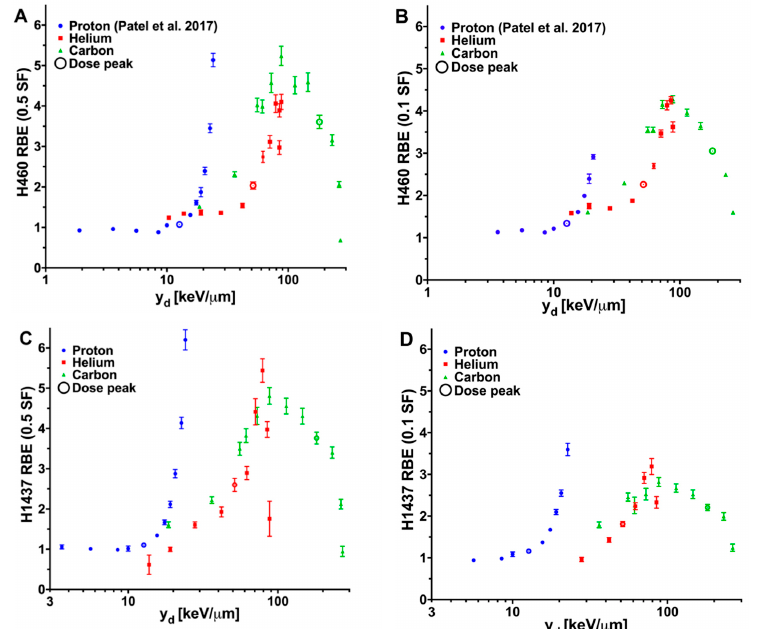
Figure 4. Proton, helium and carbon ion relative biological effectiveness (RBE) versus y d . RBEs were calculated at surviving fractions of 0.5 (RBE (0.5 SF)) and 0.1 (RBE (0.1 SF)). Irradiations at the Heidelberg Ion Therapy Center consisted of exposing cells to protons (blue), helium ions (red), and carbon ions (green). Previously published results for cells exposed to protons at the MD Anderson Proton Therapy Center are shown (purple). The location sampled closest to the Bragg peak is designated with a circle. ( A ) H460 RBE (0.5 SF). ( B ) H460 RBE (0.1 SF). ( C ) H1437 RBE (0.5 SF). ( D ) H1437 RBE (0.1 SF). The helium and carbon ion datasets demonstrated a measured increase in RBE until a y d value between 79.0 and 87.9 keV/ μ m at which point the RBEs were found to reduce from the maximum. This feature was not present in the proton RBE. Error bars are standard error. For H460 cells, the RBE for carbon ions followed a pattern similar to that of the RBE for helium ions. The entrance RBE was measured at 18.6 keV/ μ m, producing an SF (0.5) of 1.51 and an SF (0.1) of 1.60. The RBE (0.5 SF) value increased with y d to a maximum value of 5.24 at y d of 87.9 keV/ μ m (Figure 4A). The maximum RBE (0.1 SF) value of 4.28 was also found at 87.9 keV/ μ m (Figure 4B). Above this y d , the RBEs were found to decrease, with the lowest RBE (0.5 SF) of 0.68 present at the highest y d sampled, 270.3 keV/ μ m. The RBE values of helium and carbon ions for H460 cells are listed in Table 1. Table 1 . Heavy ion RBE values for H460 cells . Column